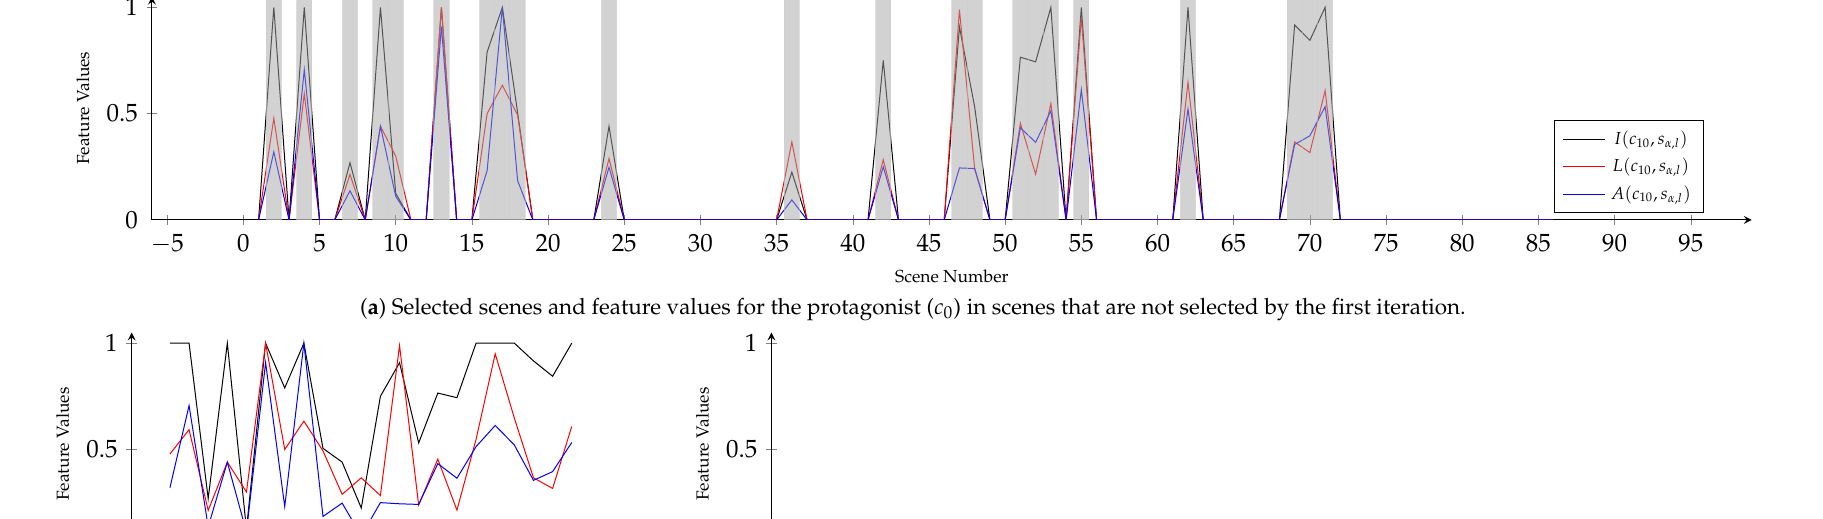
( b ) Feature values for the protagonist ( c 0 ) in the selected scenes. ( c ) Feature values for the protagonist ( c 0 ) in the remaining scenes.